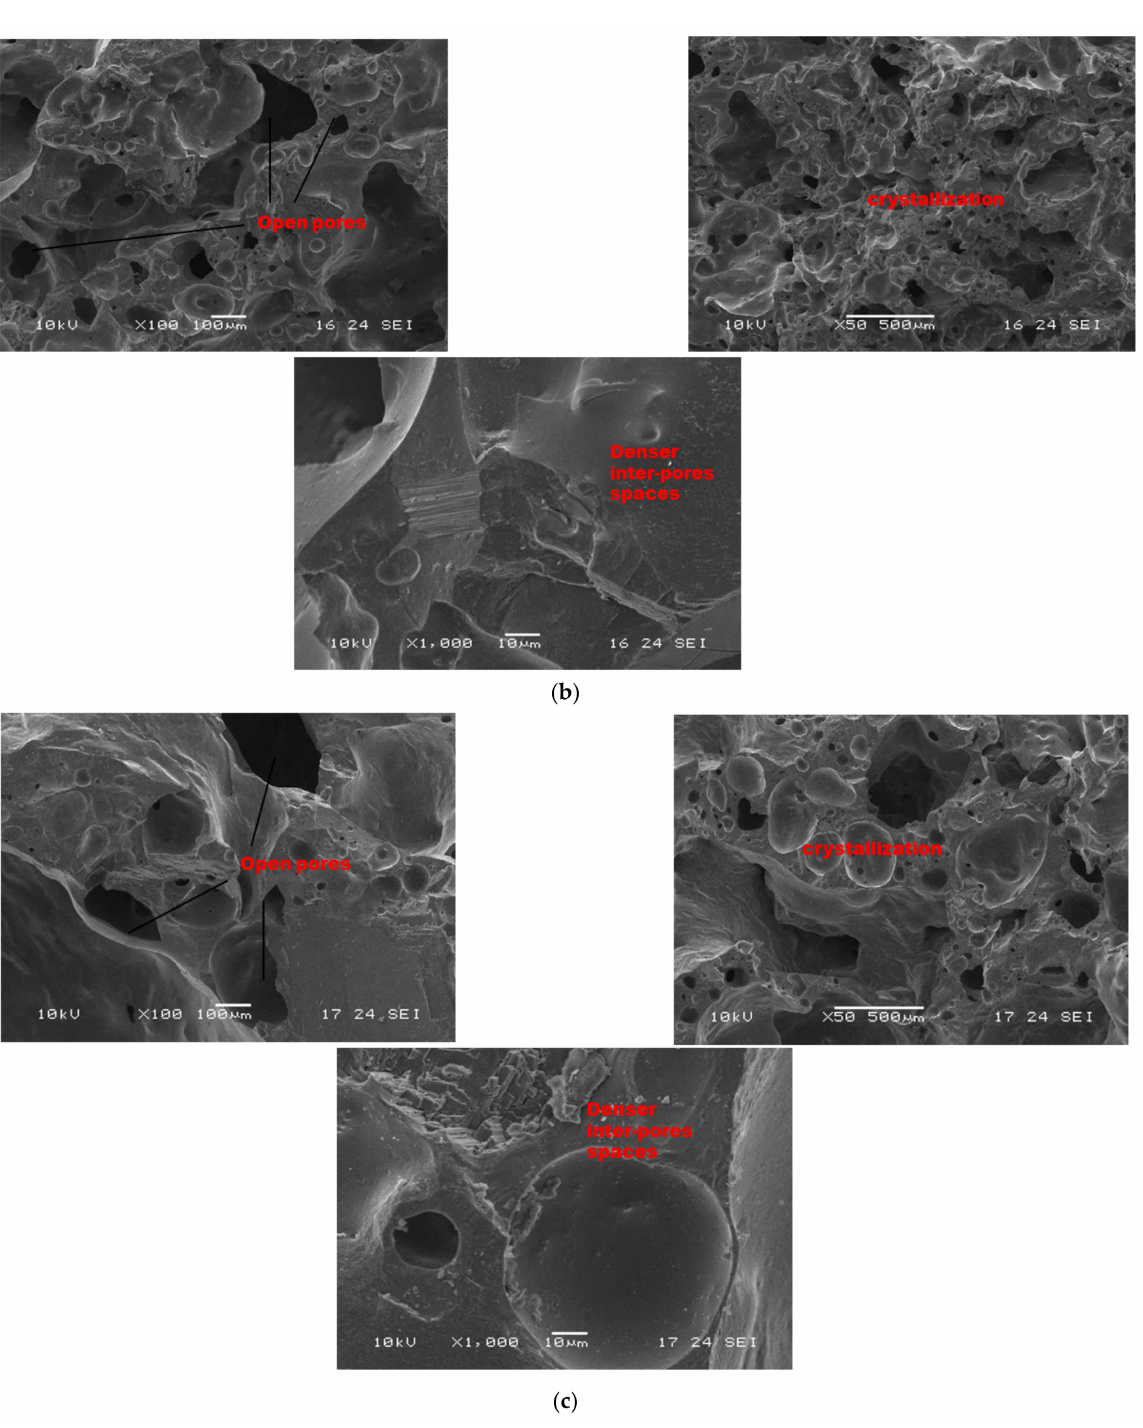
Figure 8. SEM micrographs of selected refractory geopolymer matrices (85 wt.% of kyanite) at 1250 ◦ C: ( a ) RB, ( b ) RC and ( c )